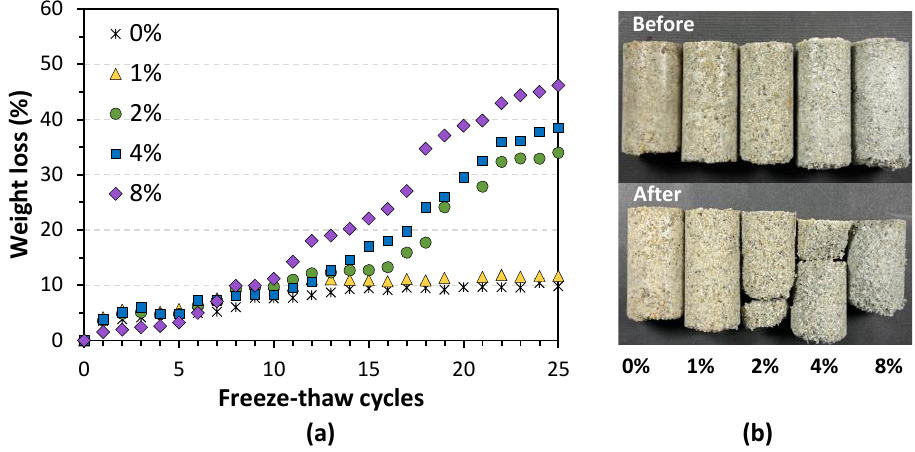
Figure 9. Sign of loss: ( a ) monitoring of weight loss of MICP-treated samples during 25 FT cycles; ( b ) physical appearance before and after 25 FT cycles.